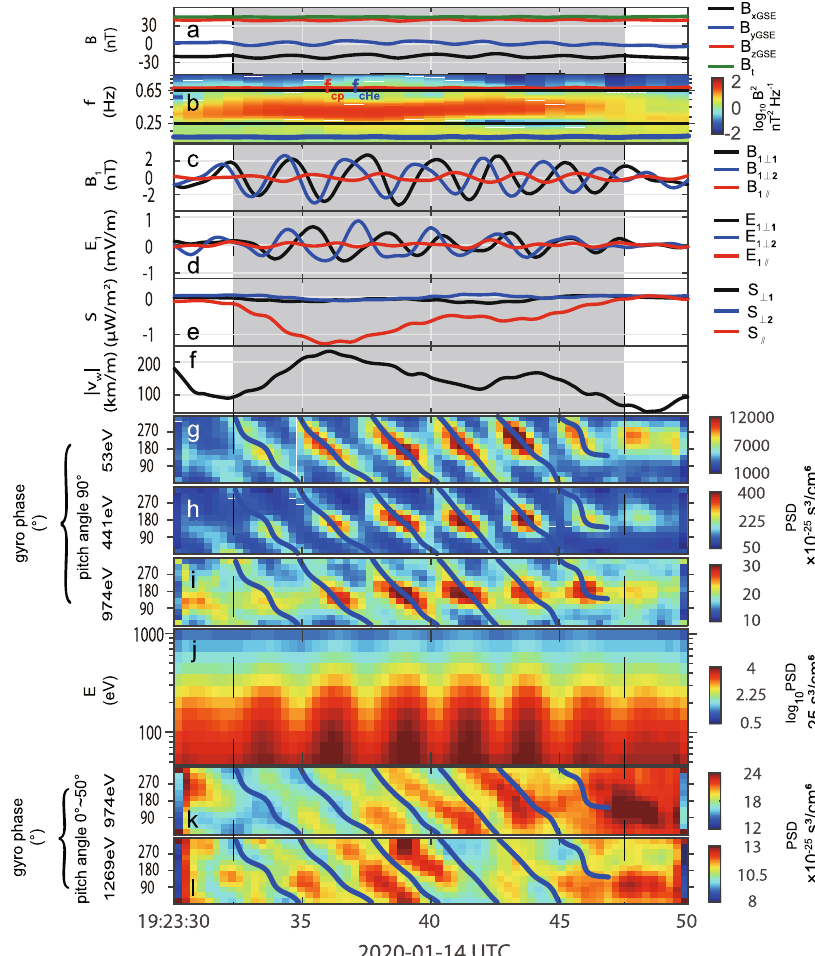
Fig. 1 MMS observations of an electromagnetic ion cyclotron wave event. a Magnetic fi elds in the Geocentric Solar Eclipse coordinates, with the x , y , z components and total magnetic fi eld strength indicated by the black, blue, red and green lines, respectively. b Wavelet power spectra of the ? 1 (cid:1) ? 2 components of B 1 . c Wave magnetic fi eld. d Wave electric fi eld. e 3-s averaged Poynting fl ux. In panels ( c – e ), the black, blue and red lines represent the ⊥ 1 , ⊥ ∥ components in the fi eld-aligned coordinates, respectively. f Wave phase speed. g – i Gyro-phase spectra of phase space density (PSD) for 2 and perpendicular-moving ions (pitch angles between 90°±11.25°) within the 53-, 441-, and 974-eV energy channels, respectively, with the phase of B 1 indicated by the blue lines. j Energy spectrum of PSD in log scale for the ions with pitch angles between 90°±11.25° and phase angle between 150° and 180°. k , l Gyro-phase spectra of PSD for ions (pitch angles between 0° – 50°) within the 974- and 1269-eV energy channels,